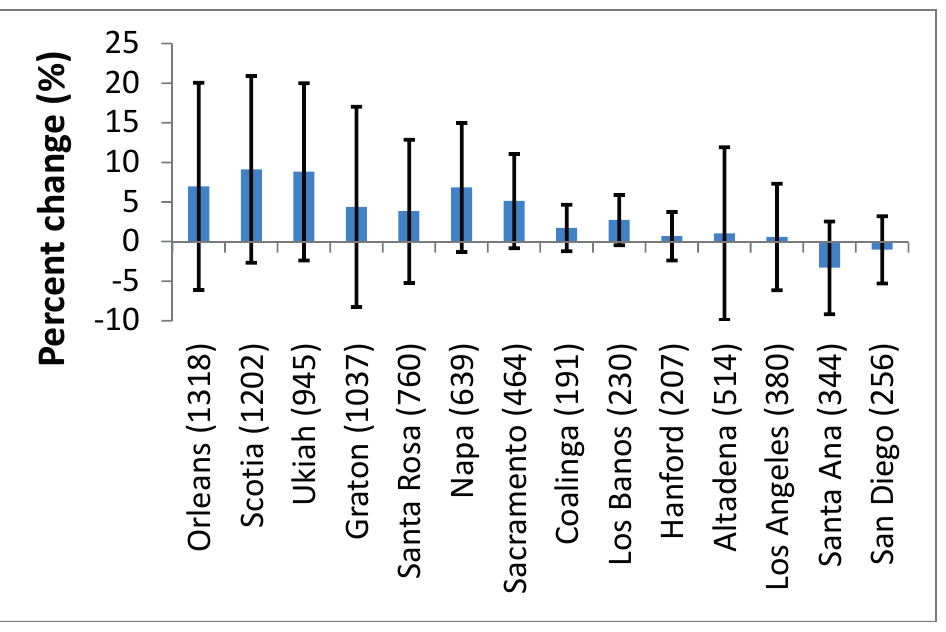
Figure 2. Graph showing percent change of total annual precipitation relative to average annual precipitation for the period 1925–2007 for stations investigated. Stations are arranged North to South with error bars (95% confidence interval). Stations in the North show positive trends, while Southern California stations show less change or decreases in rainfall over the